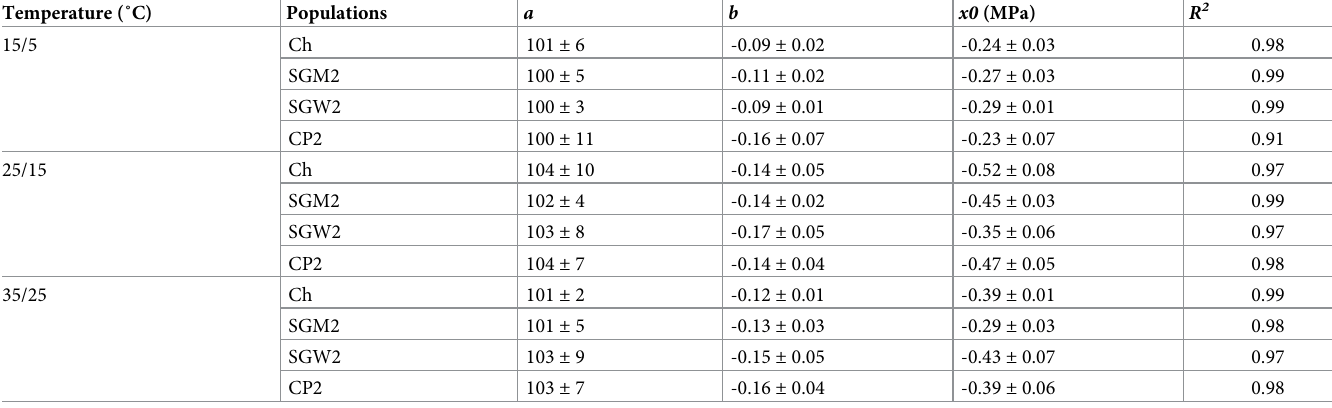
Table 2. Estimated parameters of a three-parameter sigmoidal